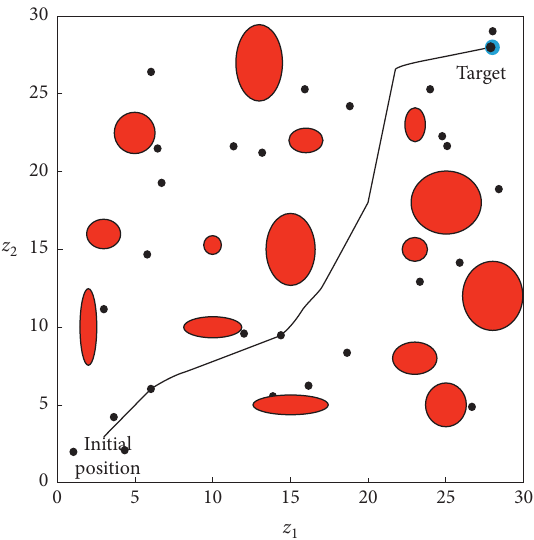
Figure 7: Landmark navigation of the 2D point robot with initial position ( 3 , 3 ) and the target placed at ( 28 , 28 ) .